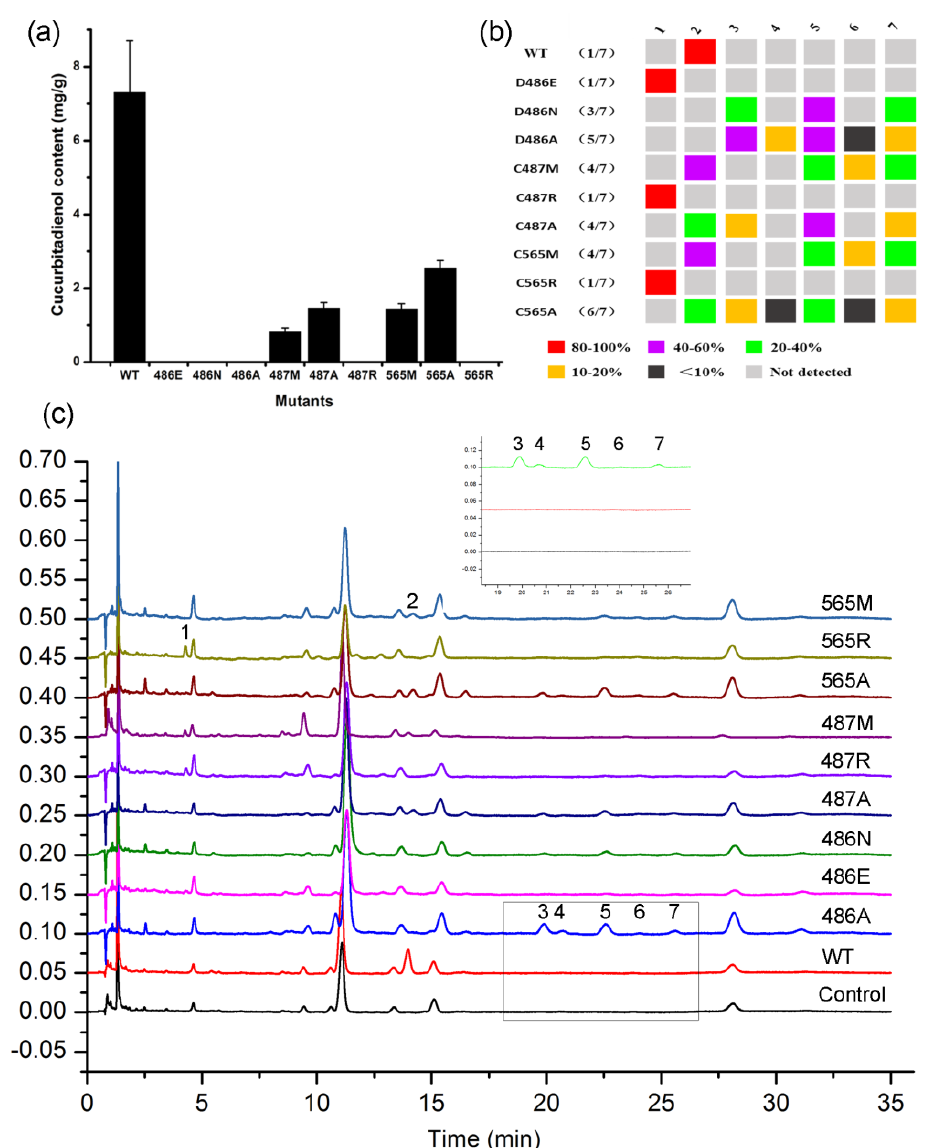
Figure 3. Product promiscuity of sgCS mutants for cyclization. ( a ) Cucurbitadienol content in SgCS mutants; ( b ) product profile of SgCS mutants; ( c ) extracted ion chromatogram of SgCS and mutants activity. The control panel (pCEV-G 4 -K m empty vector) shows the yeast BY4742 accumulate lanosterol (RT = 15.51 min) in the existence of lanosterol synthase activity. In the presence of SgCS, cucurbitadienol (compound 2 ) is